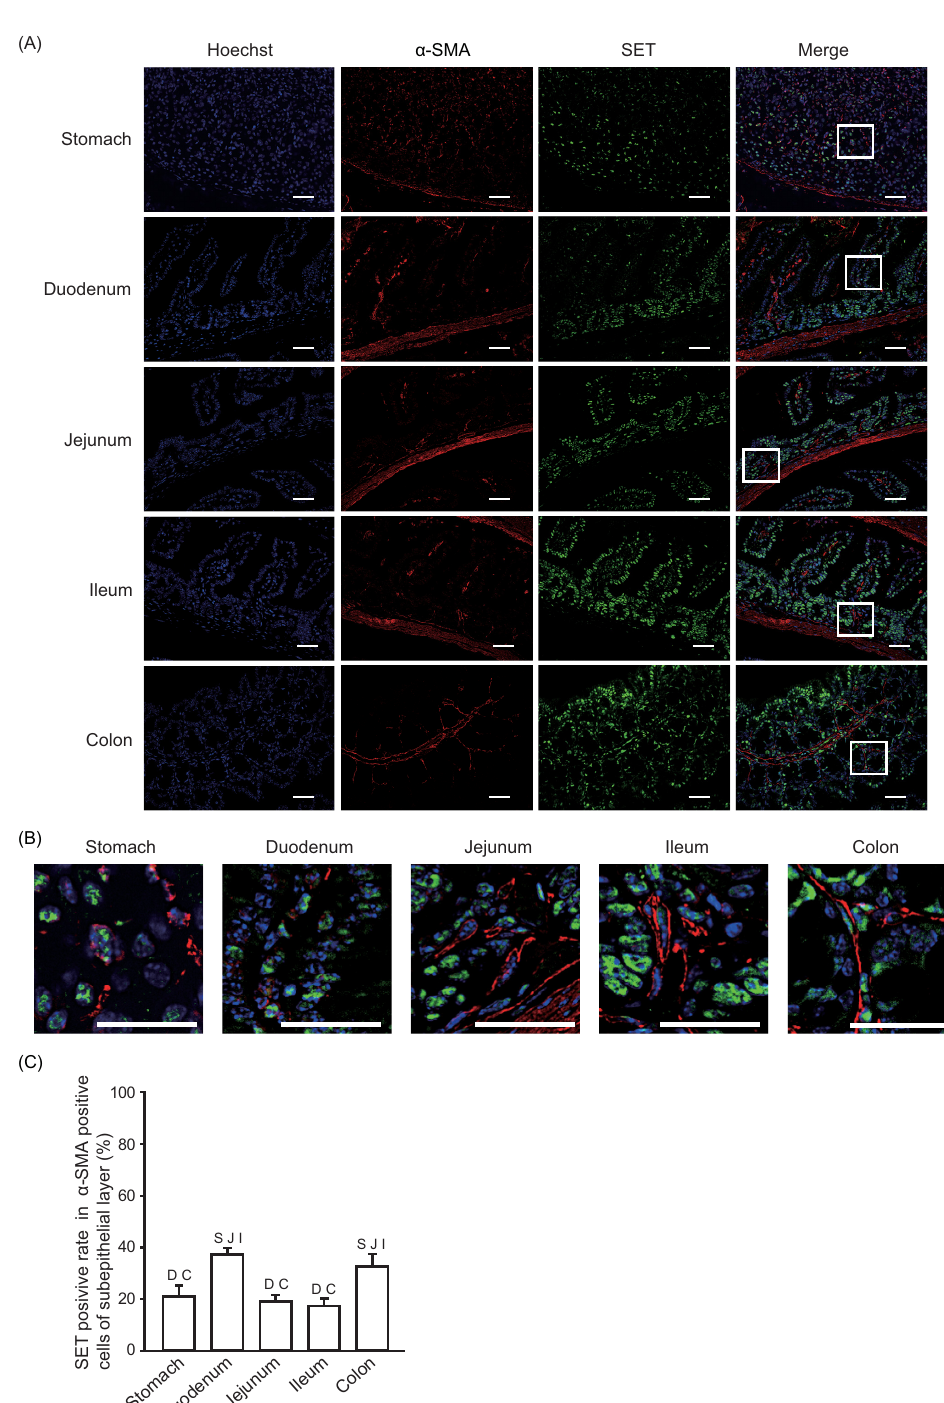
Fig 5. SET-positive rate in myofibroblasts. Immunofluorescence staining was performed to analyze SET and α -SMA expression in gastrointestinal tissues from mice. (A) Representative pictures of SET (Green), α -SMA (Red), Hoechist 33342 (Blue), and merge are shown. Enlarged pictures of indicated area in (A) are shown in (B). Scale bars: 40 μ m. (C) Quantitative data (means ± S.E.) for SET positive rate in α -SMA positive cells in subepithelial layer are shown. N = 3. S: p < 0.05 vs. Stomach, D: p < 0.05 vs. Duodenum, J: p < 0.05 vs. Jejunum, I: p < 0.05 vs. Ileum, C: p < 0.05 vs. Colon.